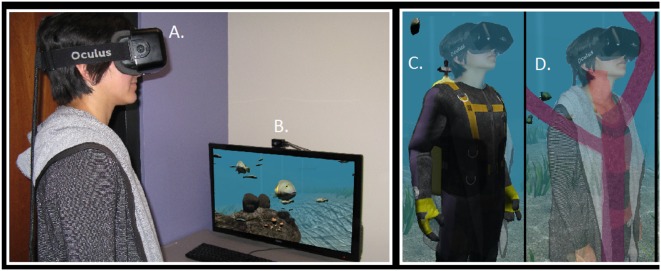
A participant experiencing the virtual environment. (A) The participant wears an Oculus Development Kit 2 (DK2) VR display, whose internal accelerometer and gyroscope track 3-degrees of orientation for the user's head. (B) The Oculus near infrared (IR) camera tracks IR sensors embedded in the DK2 headset to allow for translational tracking. The IR camera combined with the DK2's accelerometer allows for 6 degrees of freedom tracked on the user's head. (C) In the Scuba Diver condition, the user embodies a scuba diver to visit the virtual rocky reef. (D) In the Coral Condition, the user embodies a piece of coral that lives on the rocky reef.